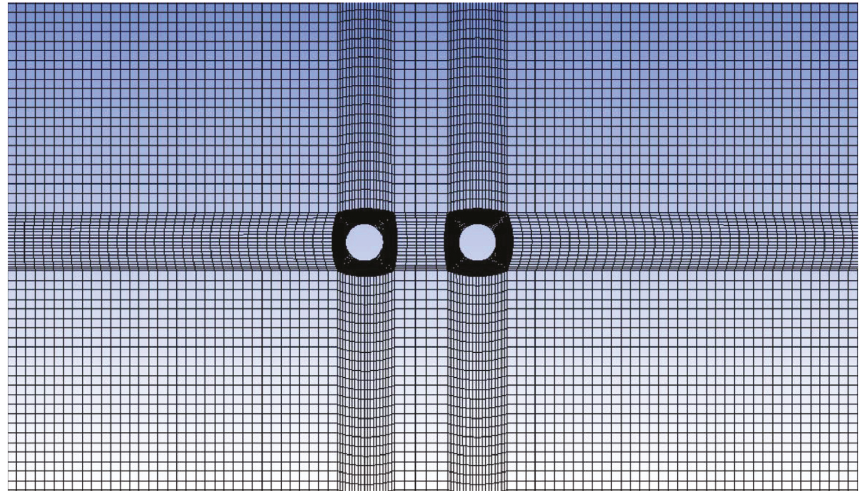
Figure 9: Model of parallel twin-tunnel and soil.